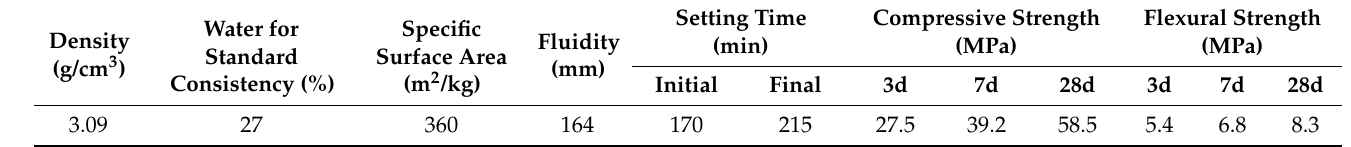
Table 2. Chemical compositions of cement, fly ash, and limestone powder. Table 3. Physical and mechanical properties of cement.